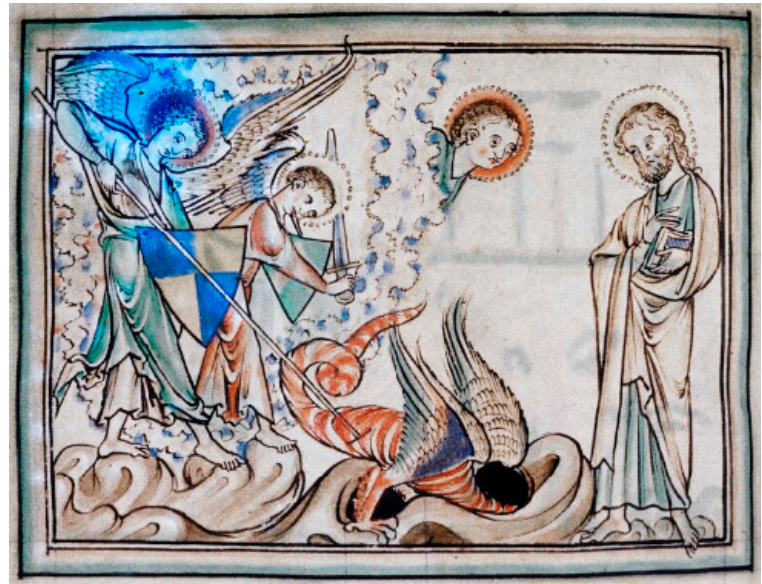
Figure 7. Tanner Apocalypse (Oxford, Bodleian Library MS Tanner 184). Fol. 66 v , c. 1250–55, ©Bodleian Libraries, University of Oxford.